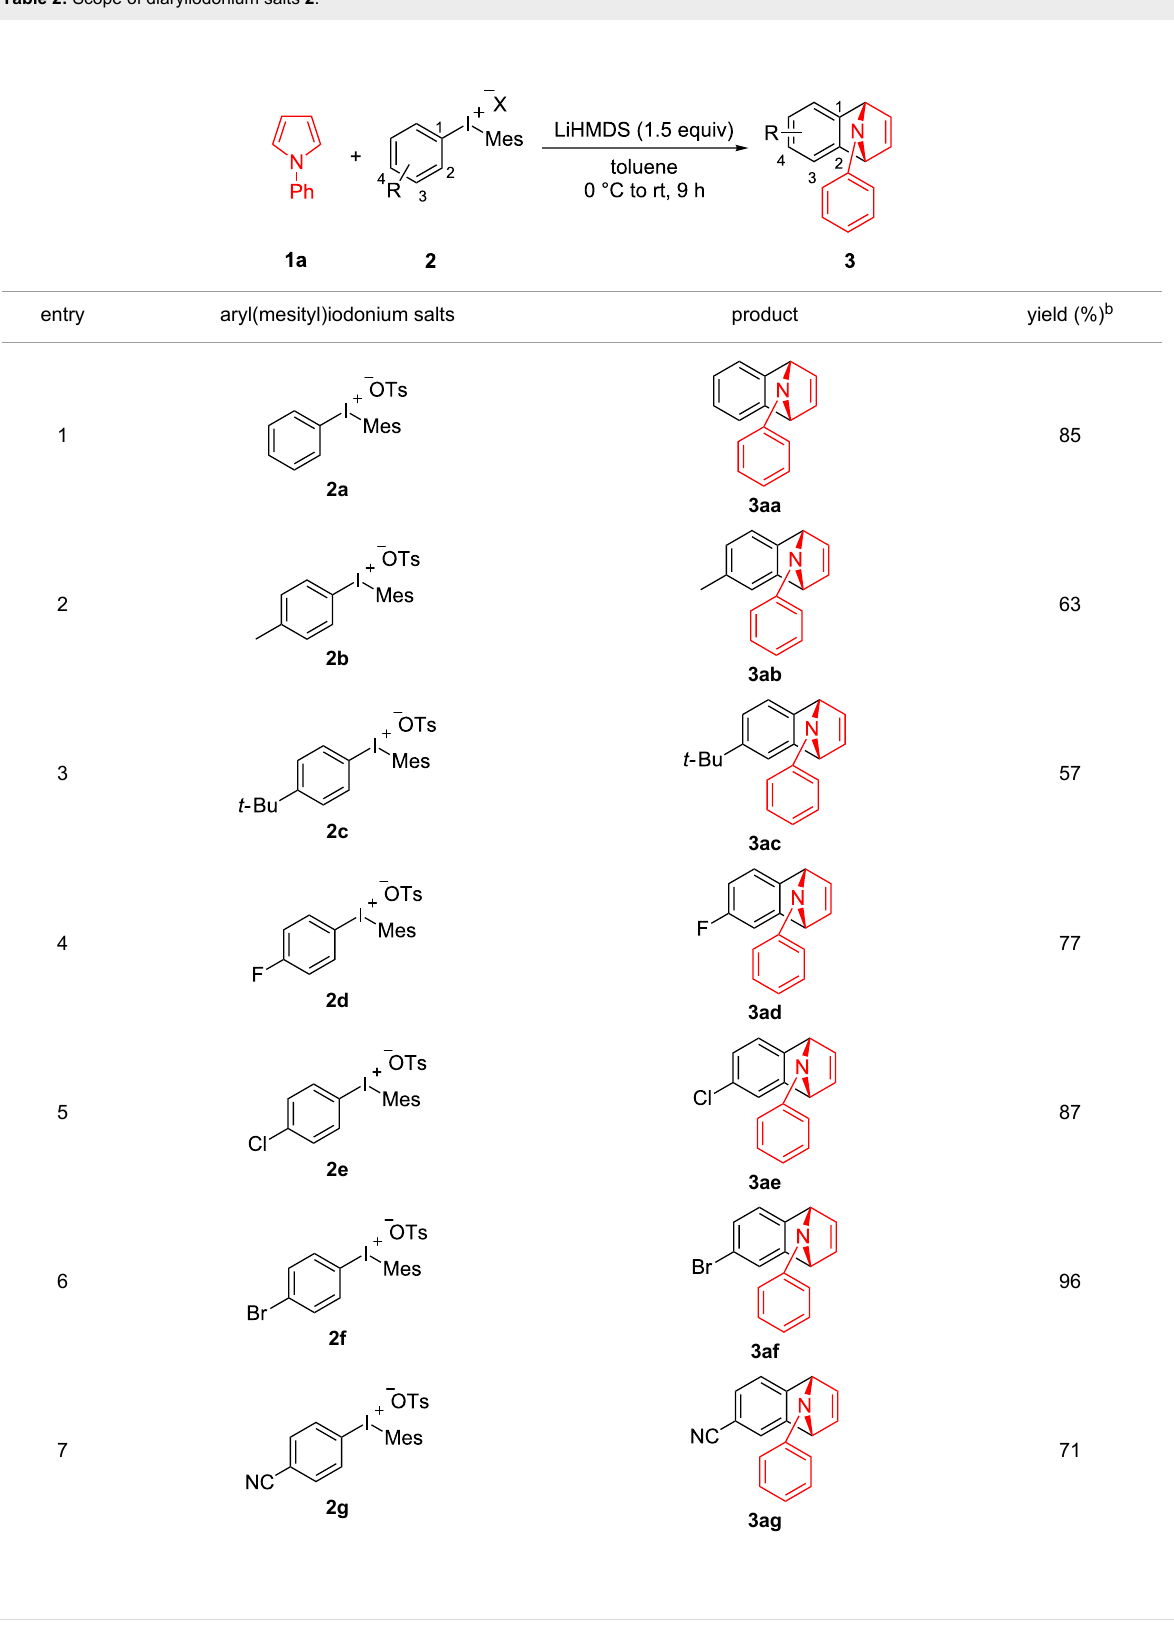
Table 2: Scope of diaryliodonium salts 2 .